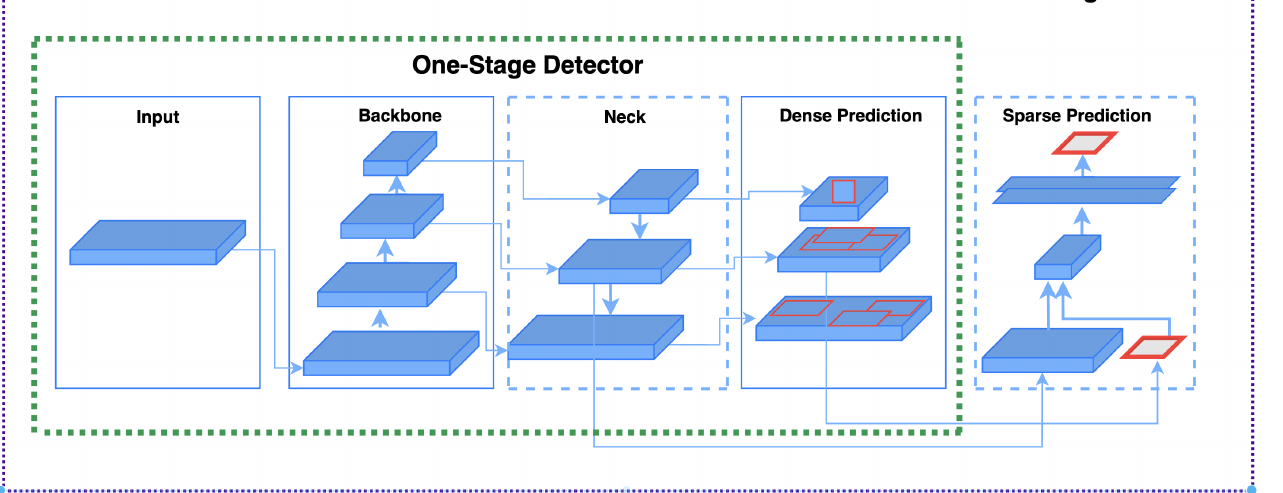
Figure 7. Yolo4 Architecture